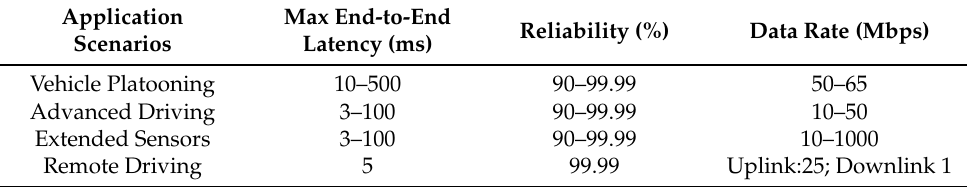
Table 1. QoS requirements of advanced V2X applications supported by